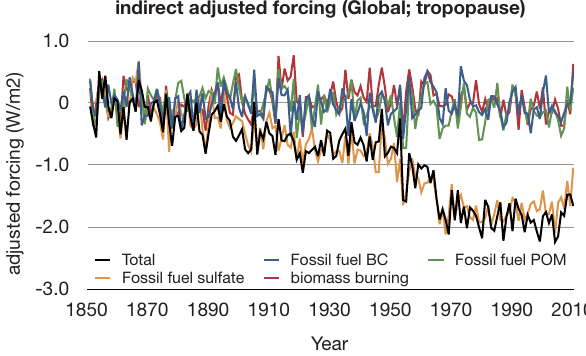
Fig. 16. Time series of annual and global mean adjusted forcing due to the indirect effect by aerosols from fossil fuel (BC, POM, and sulphate) and from biomass burning at the tropopause relative to the preindustrial experiment simulated by SPRINTARS.